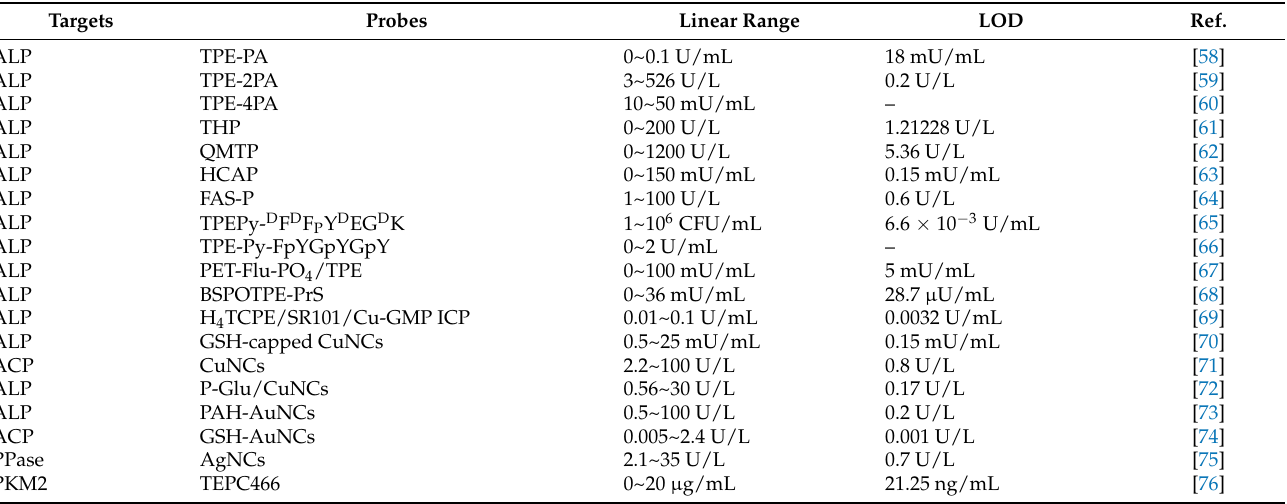
Table 2. Analytical performances of AIE-based methods for the detection of phosphatases. Targets